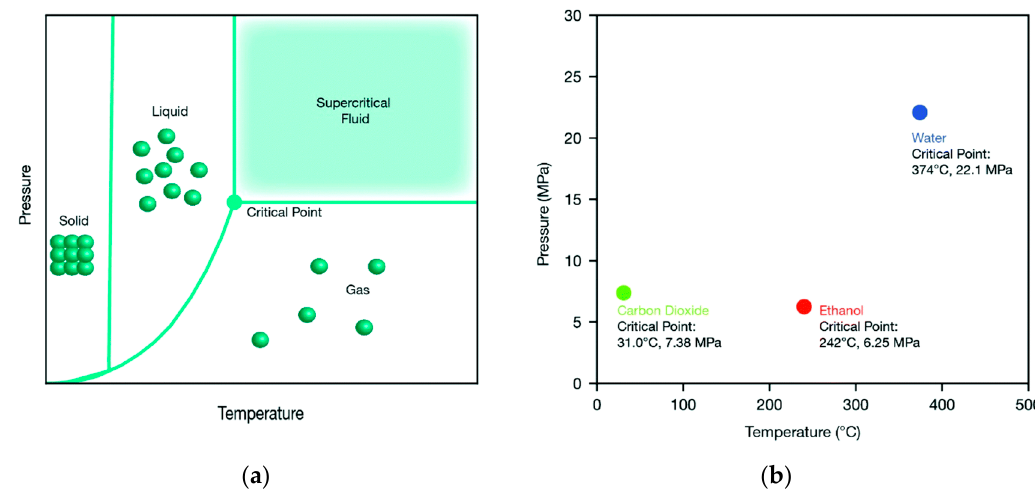
Figure 1. ( a ) Generic phase diagram highlighting the supercritical fluid region, and ( b ) critical temperatures and pressures for water, ethanol, and carbon dioxide, reproduced from [16], Copyright 2019, Royal Society of Chemistry.